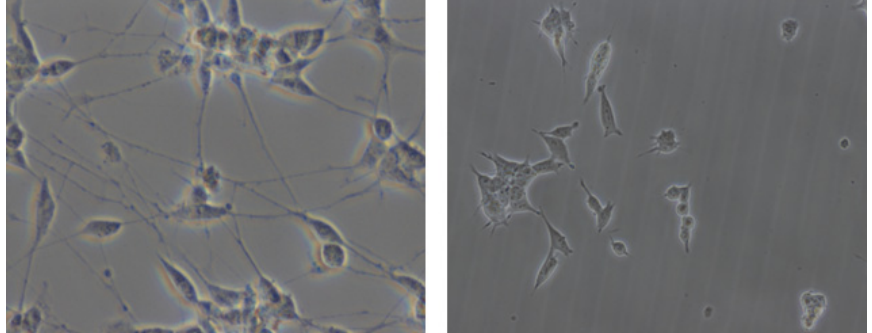
Figure 4. Phase contrast microscopy images of neurite outgrowth in differentiated, alive human neuroblastoma SH-SY5Y cells after neuroprotective treatment with 2 ng/mL BDNF /EPA, 83/2/15 mol%) with a total lipid and lipid nanoparticles (MO/DOPE-PEG 2000 concentration of 4 × 10 − 7 M ( left ), as compared to untreated SH-SY5Y cells grown in culture medium ( right ). Image size: 270 × 200 µm 2